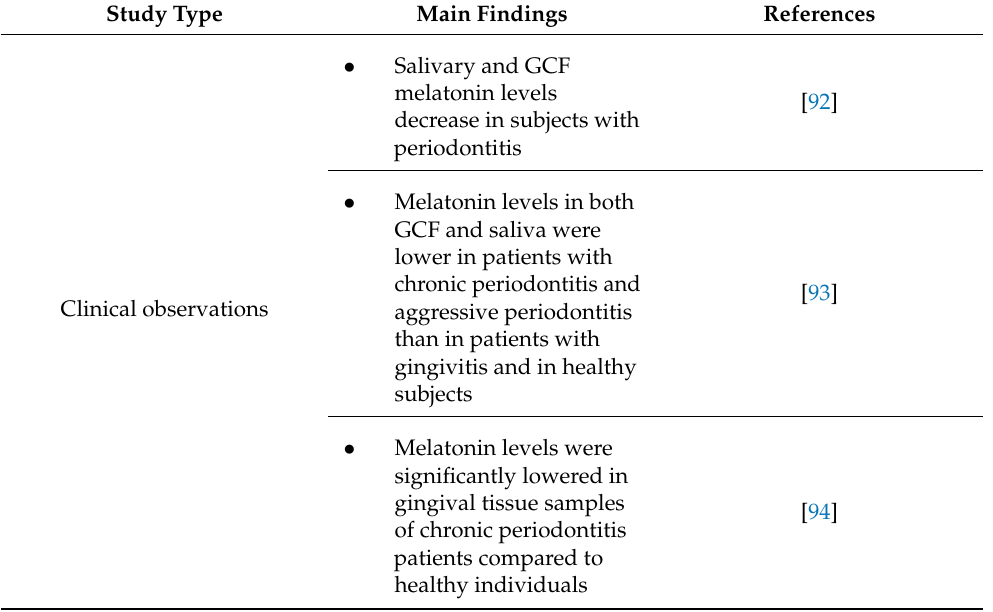
Table 1. Increasing evidence for the beneficial role of melatonin in patients with